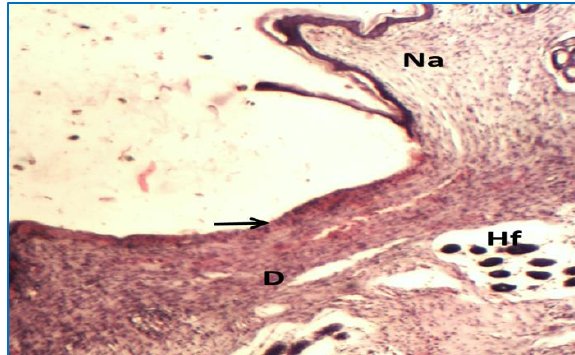
Figure, 14: Magnified section of skin (14 days post treatment with amniotic membrane) shows: marked angiogenesis within well- organized collagen bundles (Arrows), H and E,